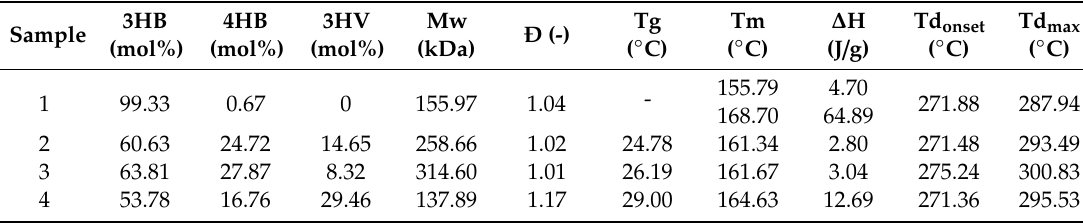
Table 4. Properties of the selected